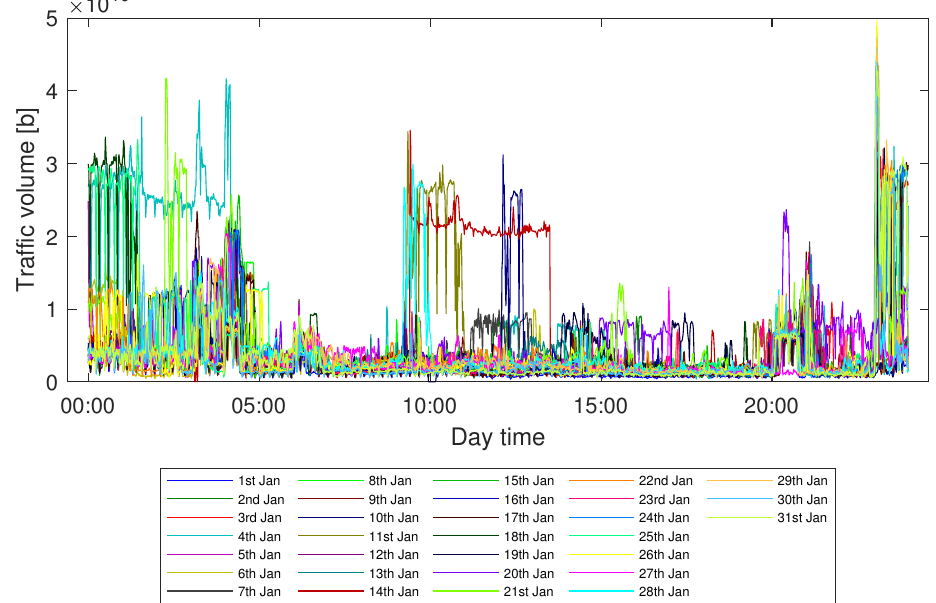
Figure 2. WASK dataset presentation: traffic observed each day in January